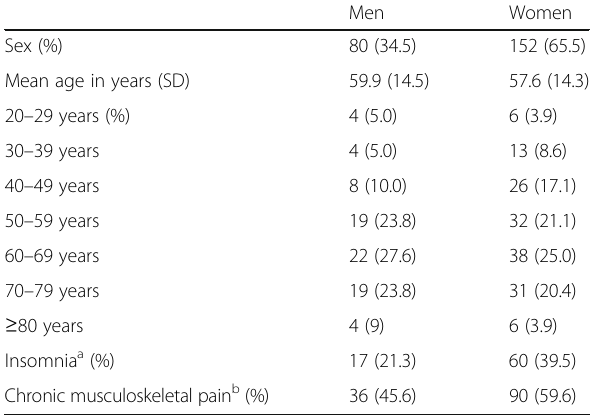
Table 1 Characteristics of the study population ( n